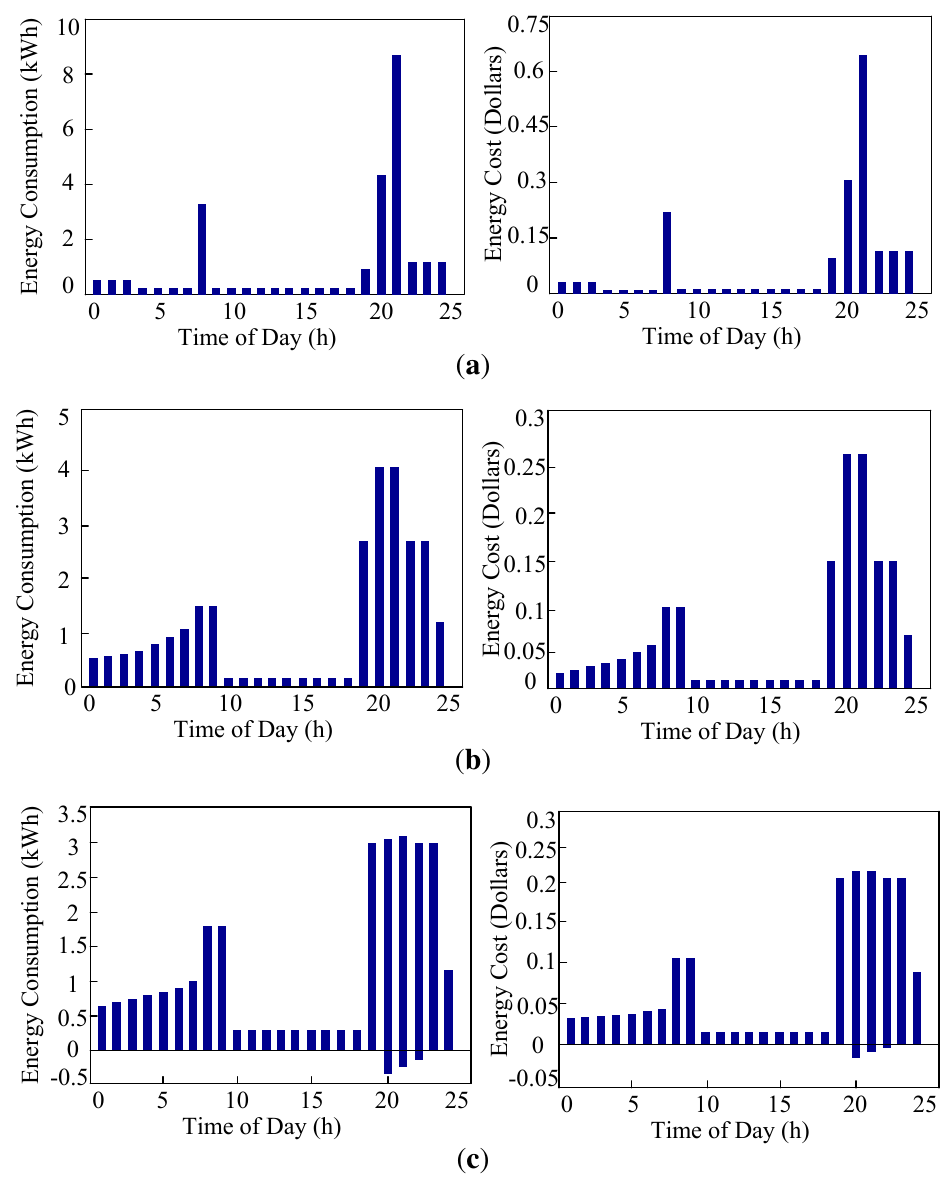
Figure 5. Scheduled energy consumption and corresponding cost of the aggregate five users having household appliances and plug-in electric bicycles (PEB). ( a ) No ECS; ( b ) ECS without PEB discharging; ( c ) ECS with PEB